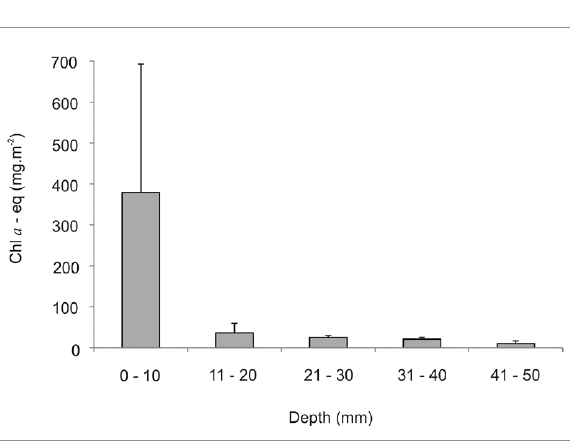
Figure 4: Dissolved inorganic nitrogen (DIN, white bars) and phosphorus (DIP, grey bars) concentrations (±SD) measured in stromatolite pools during October 2013.